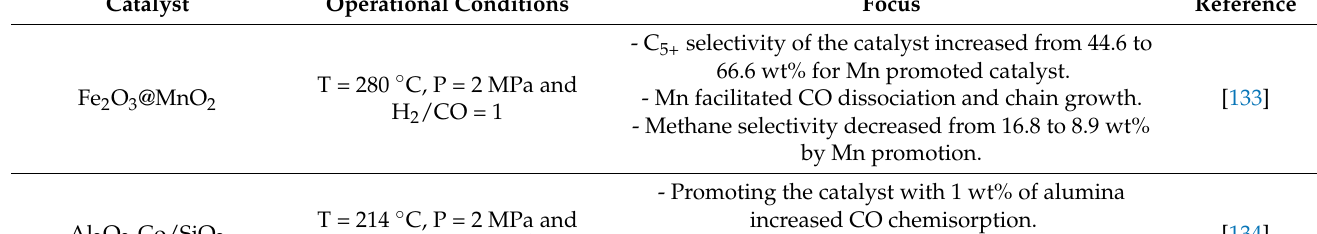
Table 9. Effects of active metal, support, and promoter nature on C 5+ selectivity of Fe- and Co-based FT catalysts. Catalyst Operational Conditions Focus